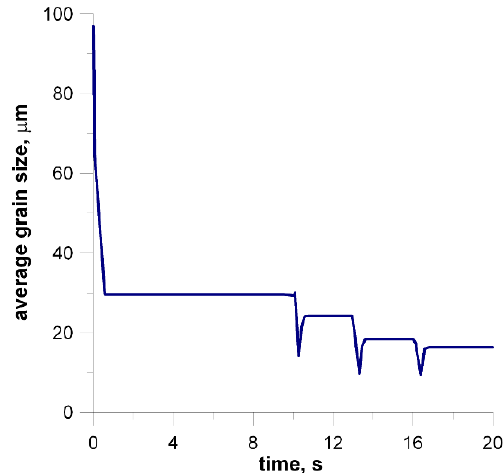
Figure 20. Changes in average grain size.